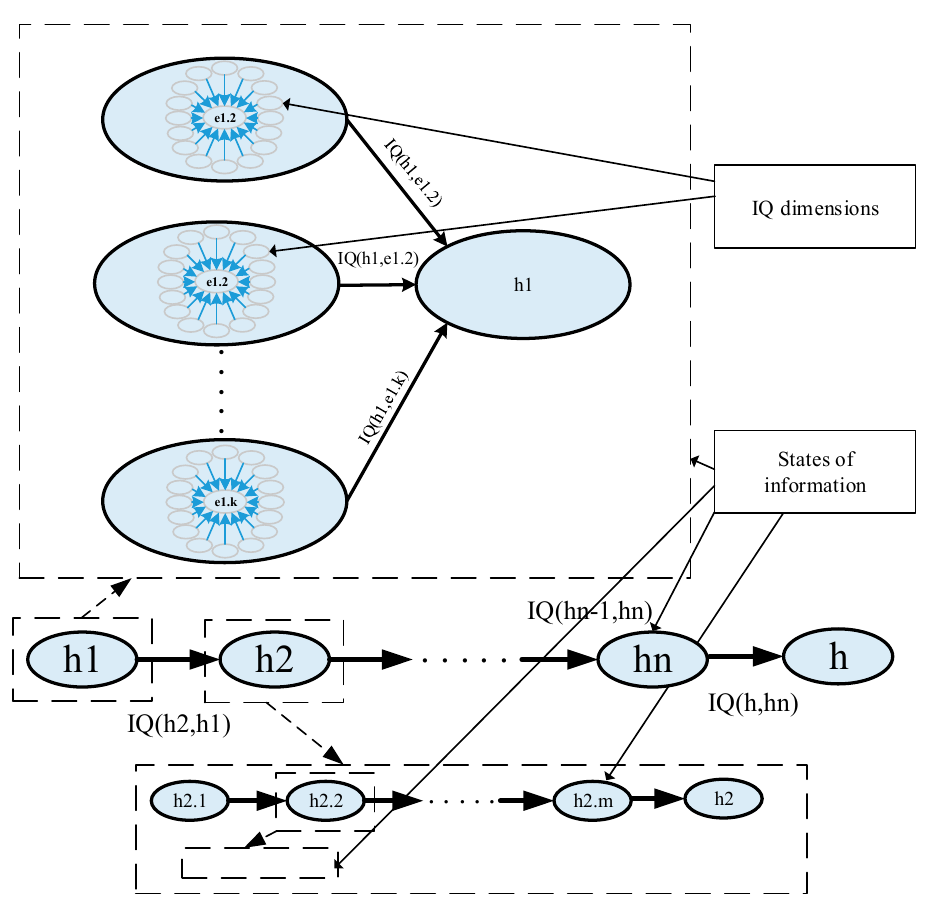
Figure 6. Diagram of the general information quality model of an information system [40].